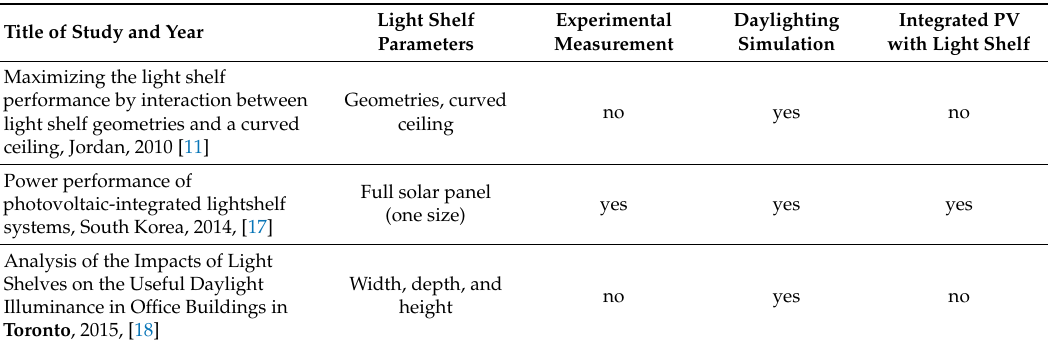
Table 1. Studies conducted on light shelf performance on